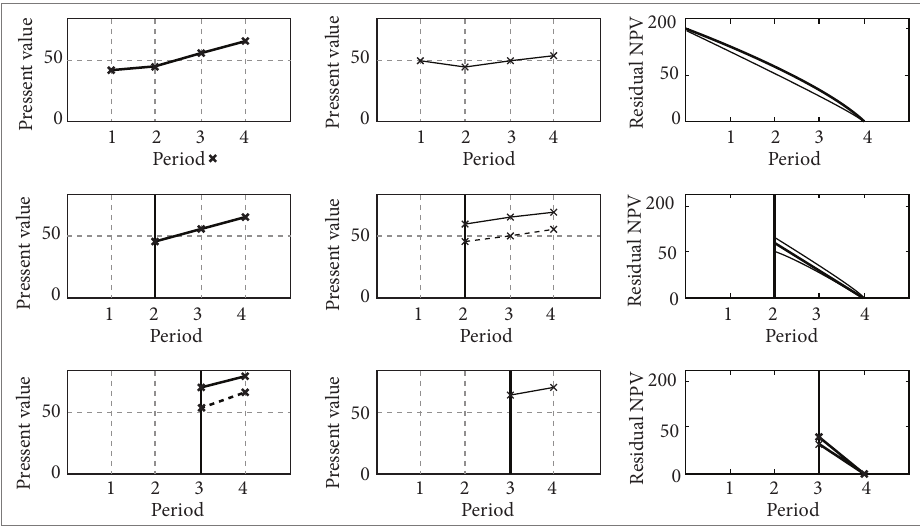
Fig. 6. Ideal-typical example of low agent switching costs and public information about the suppliers’ maximal bids, present values of both suppliers (left, middle columns) and comparison of residual net present values (right column), suddenly changed situations because of 2 shocks in the 2 nd and 3 rd rounds (middle, lower